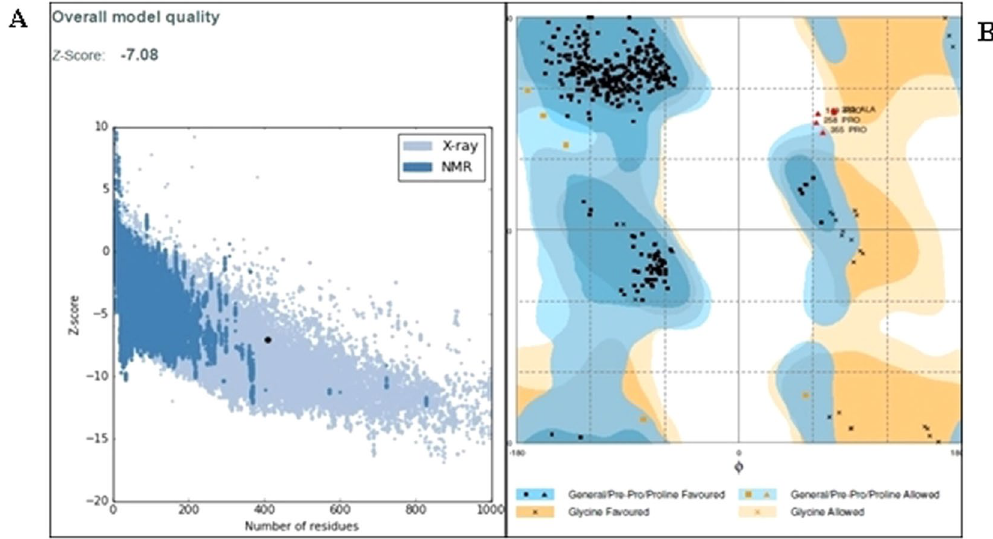
Figure 4. Validation of 3D hemolin protein model. ( A ) PROSA validation showing Z- Score ( − 7.08) and ( B ). Ramachandran plot analysis of structure showing 97.8%, 1.2% and 1.0%residues in favored, allowed and disallowed region.